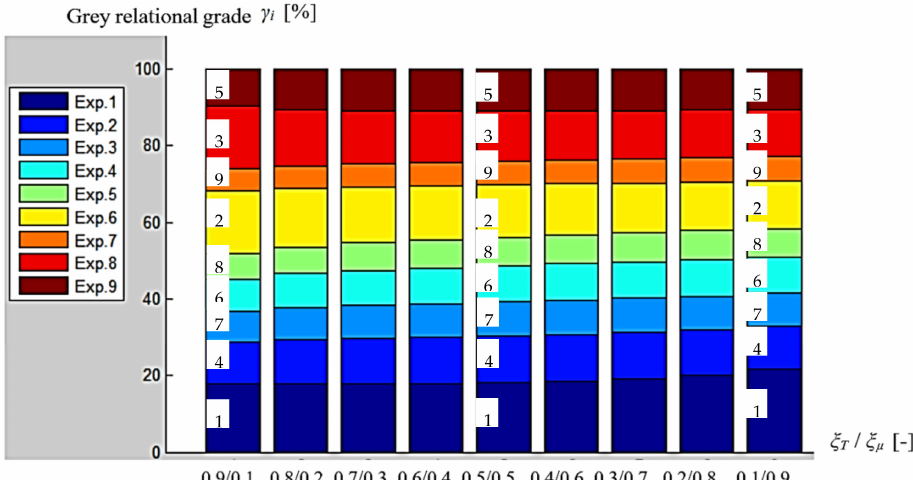
Figure 3. Influence exerted by the decrease of the ratio ξ T / ξµ on the size of the grey relational grade γ , for all nine experimental tests, in the case of using polyester that includes particles of